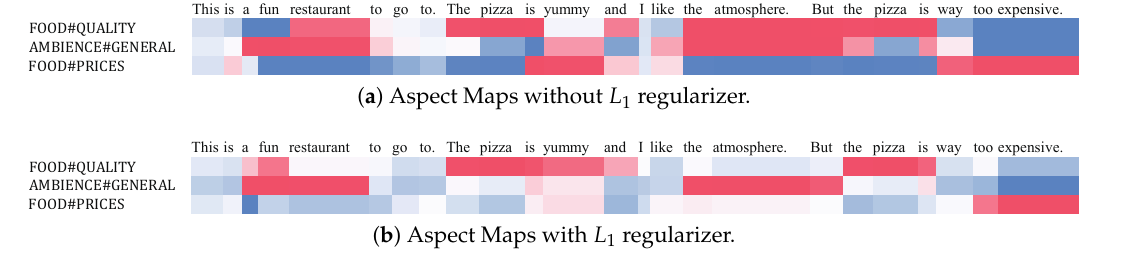
Figure 8. Aspect maps for three aspect categories over a restaurant